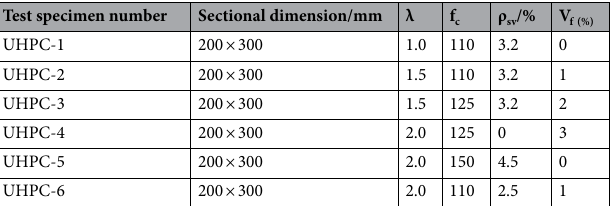
Table 1. Specimen design parameters.